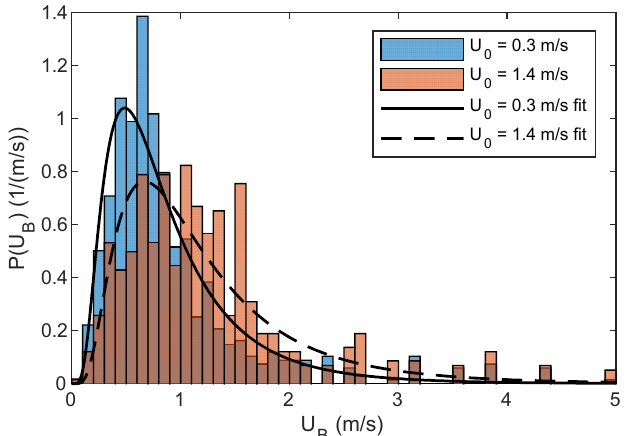
Figure 5. Probability density histogram of the bubble velocity measured at the center (r/R = 0) of the fluidized bed at D = 0.1 m, H 0 = 0.3 m and z = 0.1 m at bubbling fluidization ( U 0 = 0.3 m/s) and turbulent fluidization ( U 0 = 1.4 m/s) and their fitted log-normal distributions.